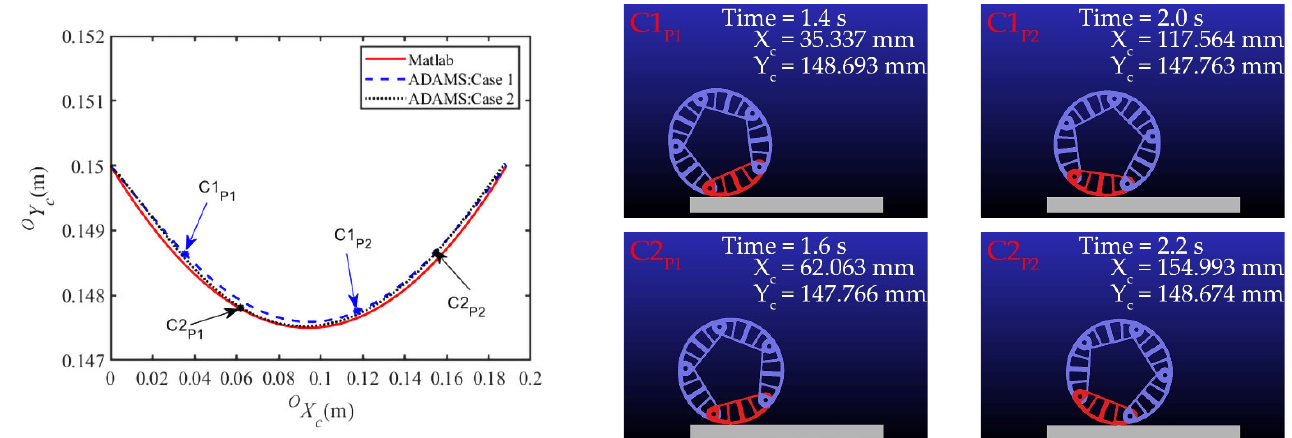
Figure 16. Theoretical and simulated trajectories of the CoM at h = 0.145 m.